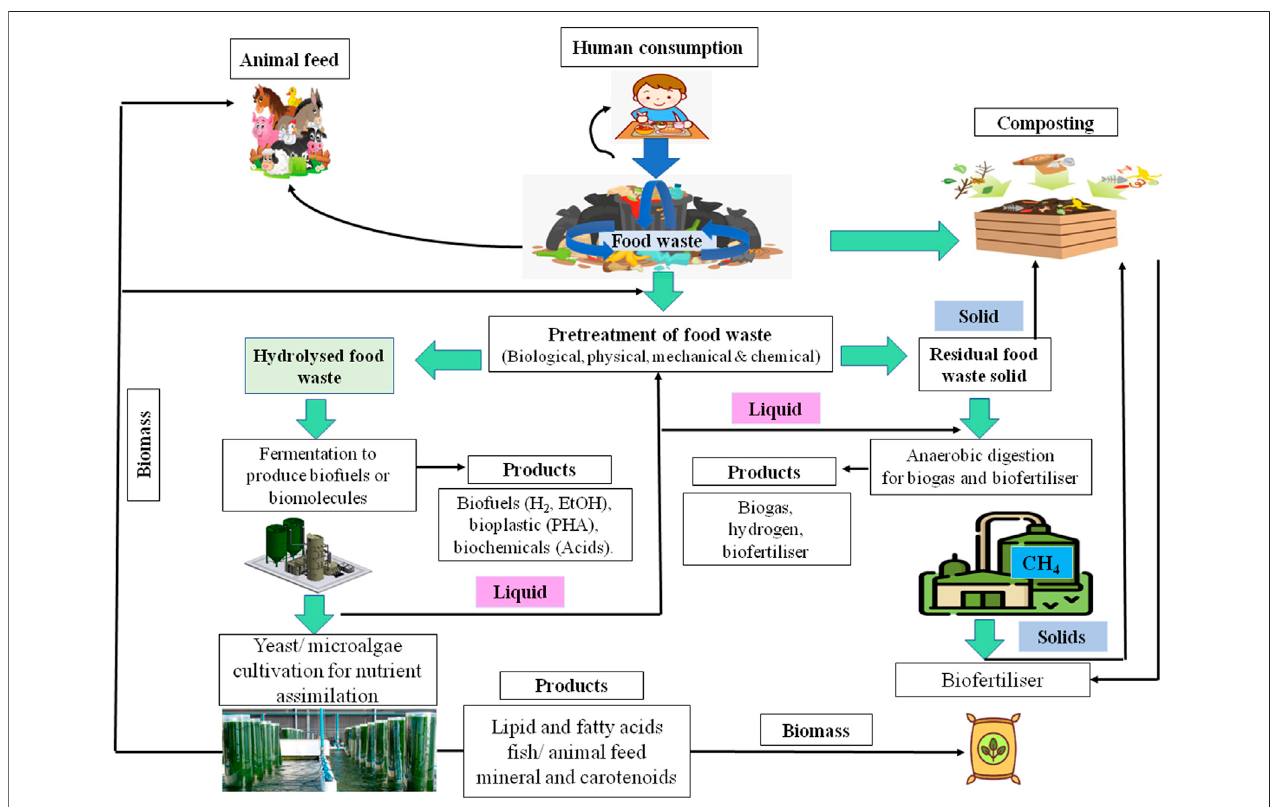
FIGURE 1 | FW-based circular bioeconomy approach for sustainable development.